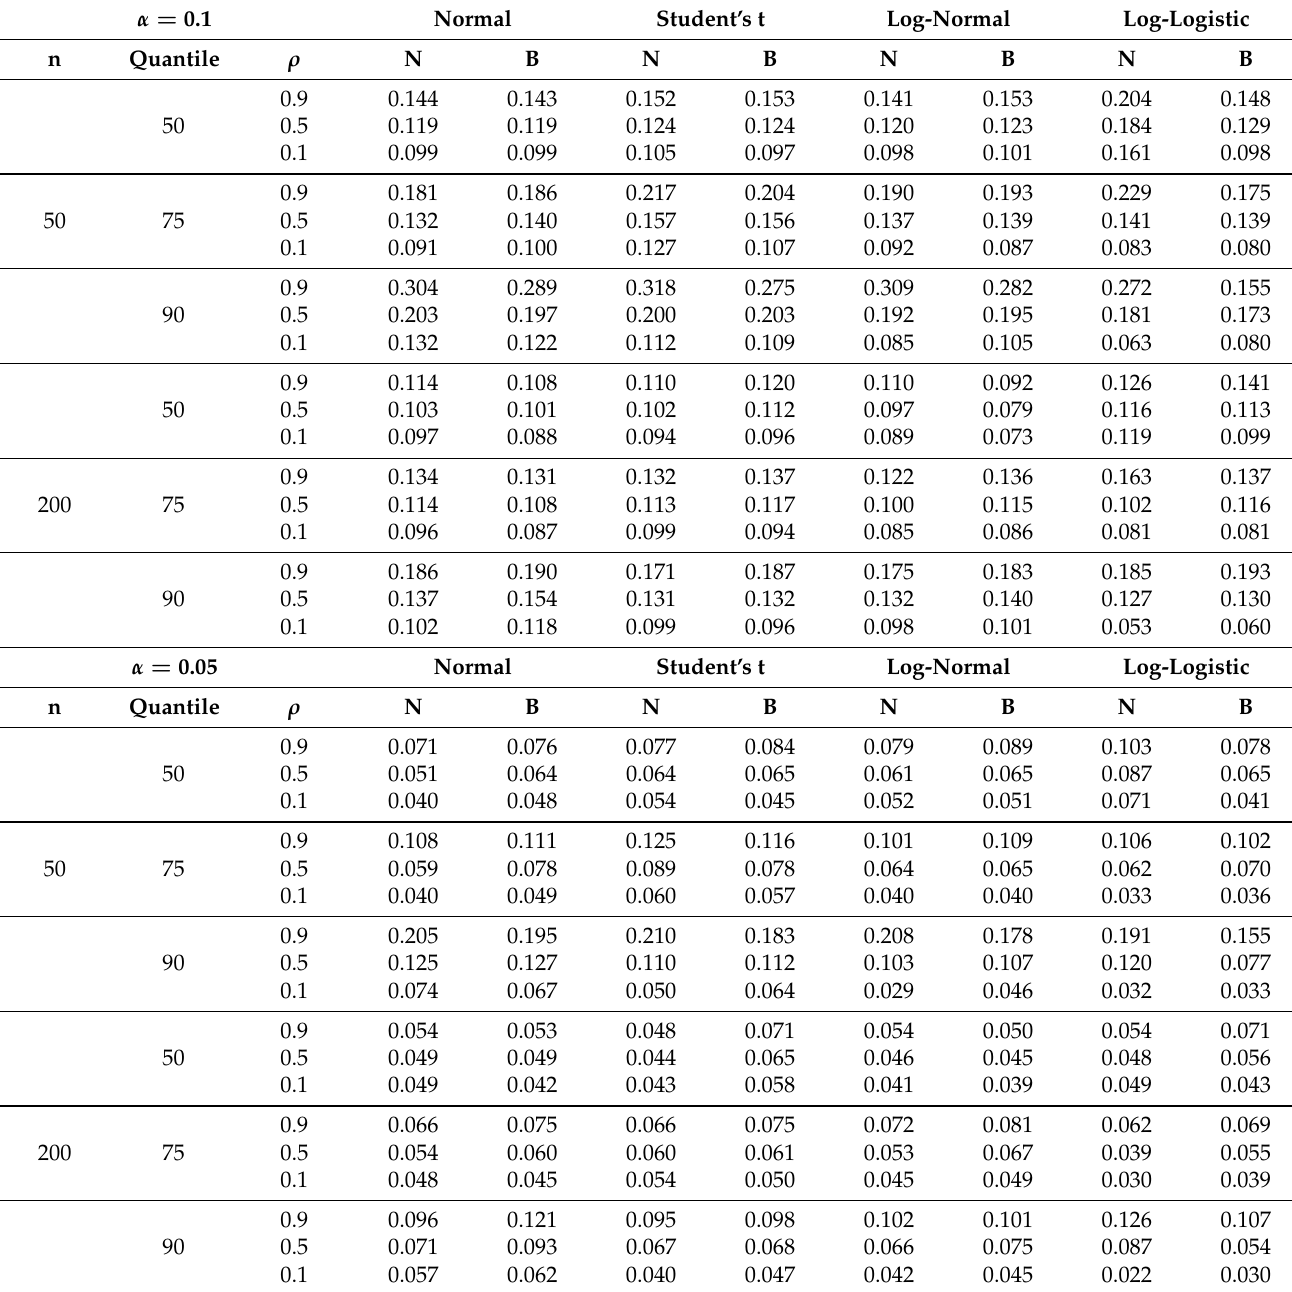
Table 2. Simulation results for local Moran statistic with maximum number of neighbours